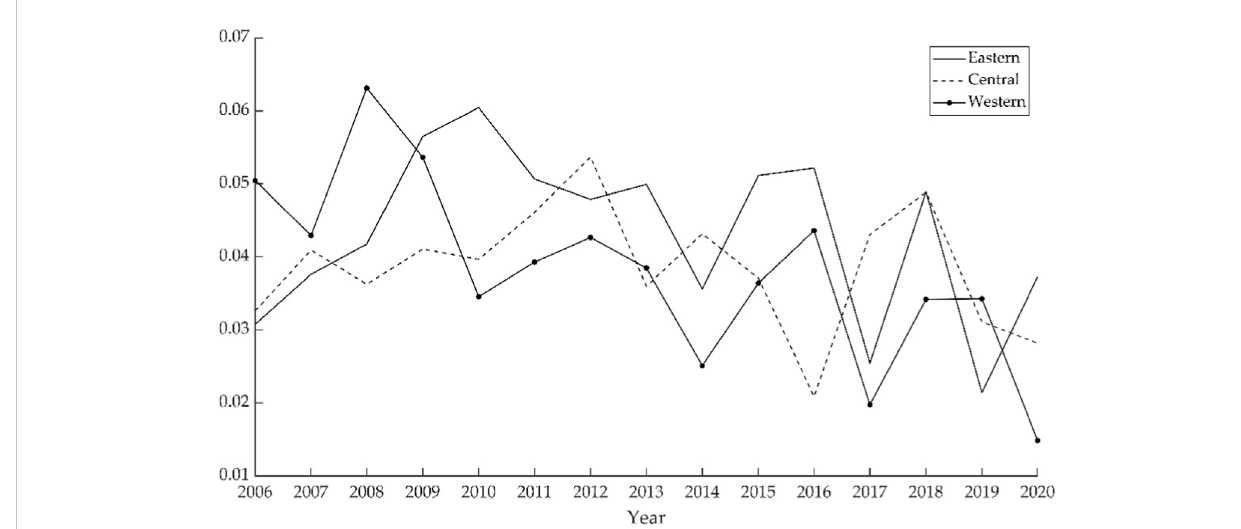
FIGURE 3 Regional difference line map of green development quality in the construction industry.